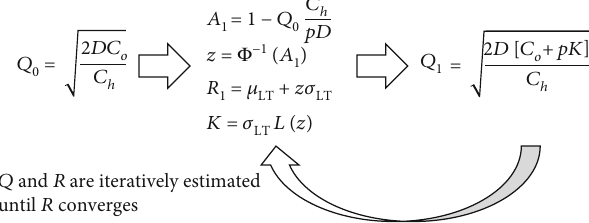
Figure 4: Estimation process of the inventory control policy under the ( Q , R ) model